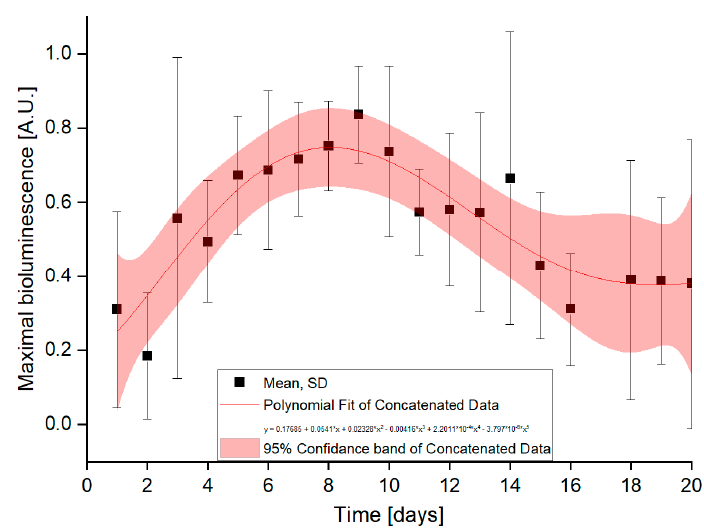
Figure 6. Daily bioluminescence maxima normalized to 1. Aggregated data from the five OFEs plus one OFE from reference [19].